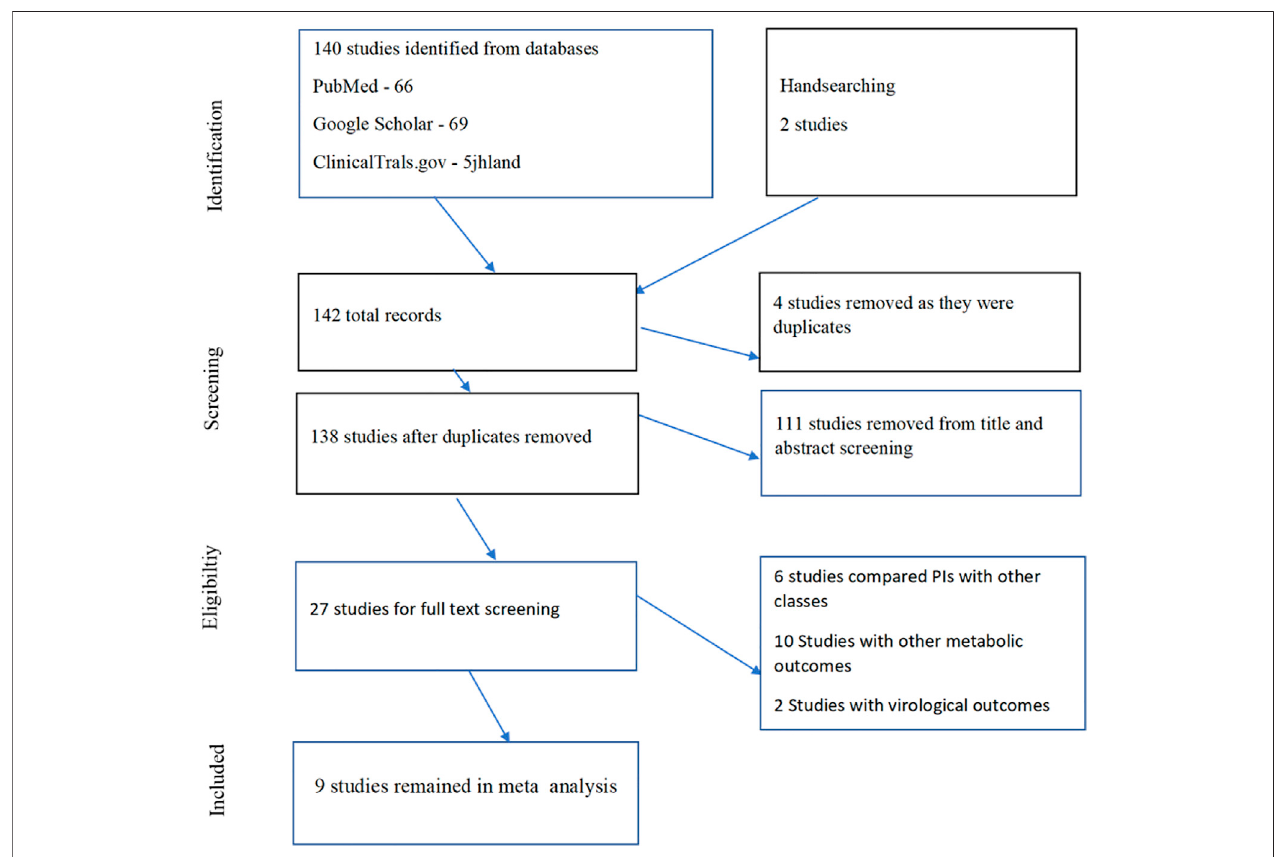
FIGURE 1 | Study fl ow